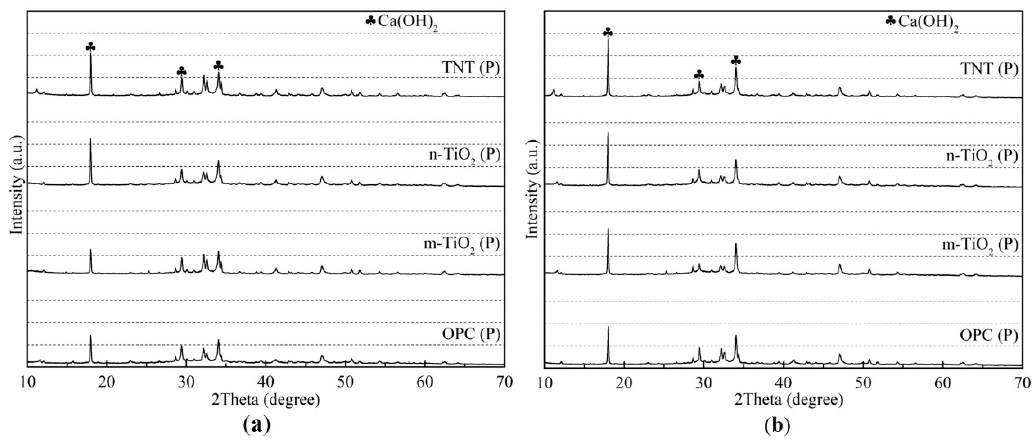
Figure 7. XRD patterns of the cement pastes after ( a ) 1 day and ( b ) 28 days of curing.